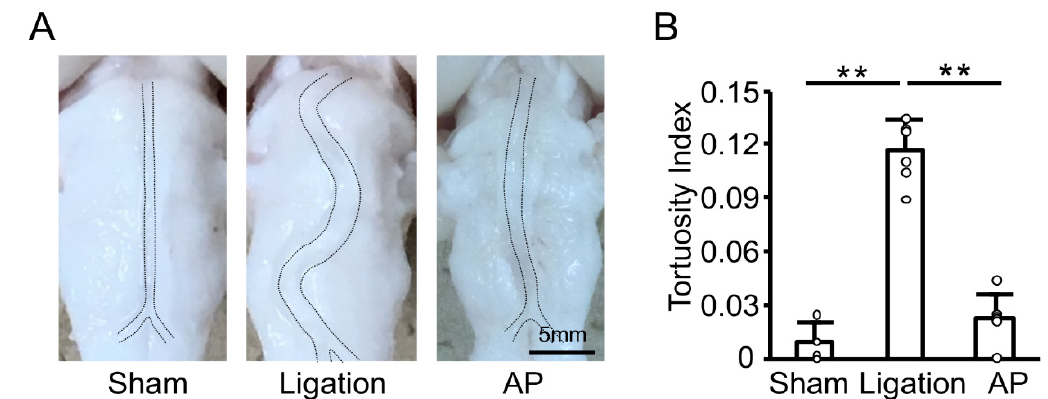
Figure 3. Antioxidant treatment suppresses vascular tortuosity in rabbits: ( A ) Representative images of fixed basilar arteries at 12 weeks after bilateral CCA ligation. AP: apple polyphenol treatment group. ( B ) Tortuosity index of fixed basilar arteries at 12 weeks after bilateral CCA ligation. n = 4 for Sham group. n = 6 for Ligation and AP group. ** p < 0.01.